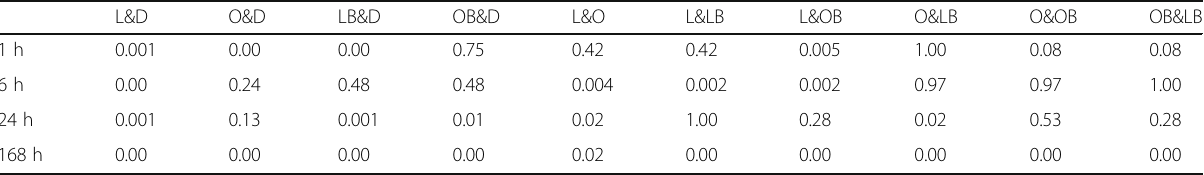
Table 2 Release of chromium ions from NiTi wires at various